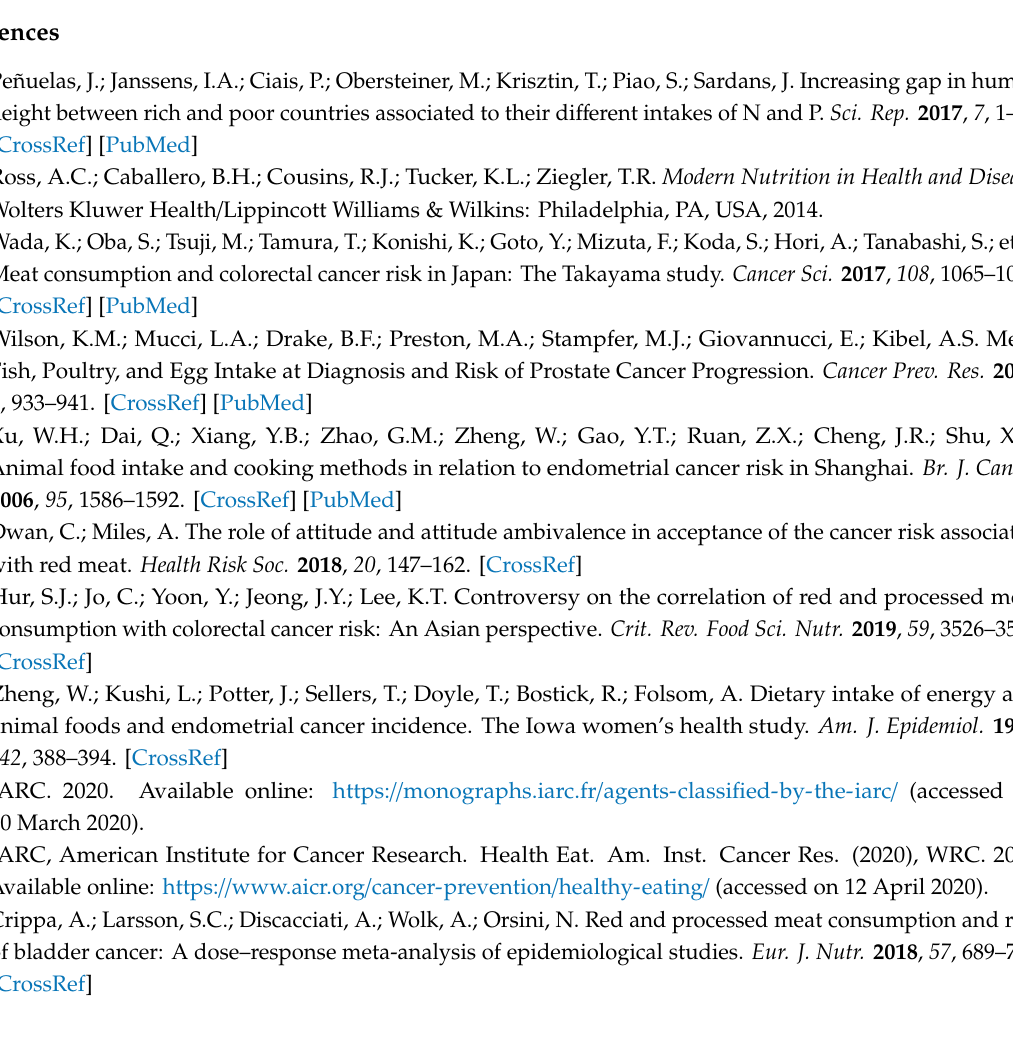
GDP), the human development index (HDI), mean age of the population (MA), life expectancy at birth (LE), and mean per capita intake of food from di ff erent sources. Results are provided for standardized variables. Table S7: Relationships within countries between national total mortality from malignant neoplasms of the colon, prostate, breast, cervix, and lung (period 1960–2010) and various traits of annual per capita intake during the same period. The bold type indicates statistical significance ( p < 0.01). Table S8: Best linear models accounting for mortality from malignant neoplasms (total (TN), colon (CN), cervix (CEN), breast (BN), prostate (PN), and lung (LN) neoplasms as functions of national per capita wealth (using GDP), the human development index (HDI), mean age of the population (MA), life expectancy at birth (LE), and mean per capita intake of food from di ff erent sources. Table S9: Country relationships between national life expectancy at birth (period 1960–2010) and various traits of annual per capita intake during the same period. The bold type indicates statistical significance ( p < 0.01). Author Contributions: J.P. and J.S. designed the study; J.P., J.S. and T.K. gathered the data and analyzed them;